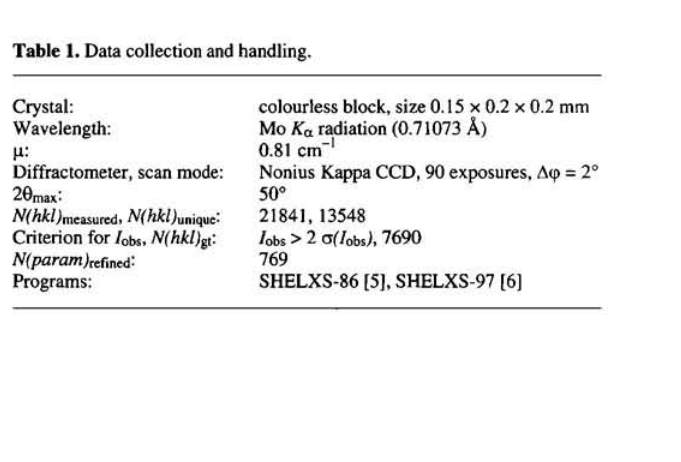
Table 1. Data collection and